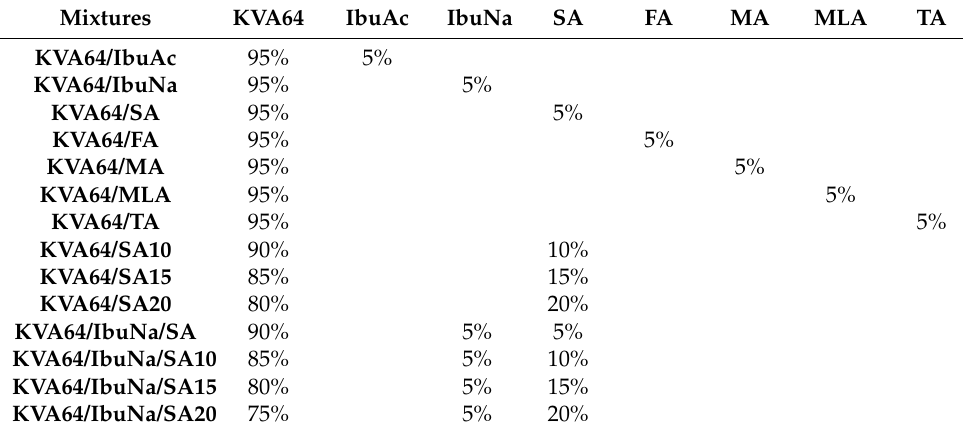
Table 1. Composition of the different mixtures.